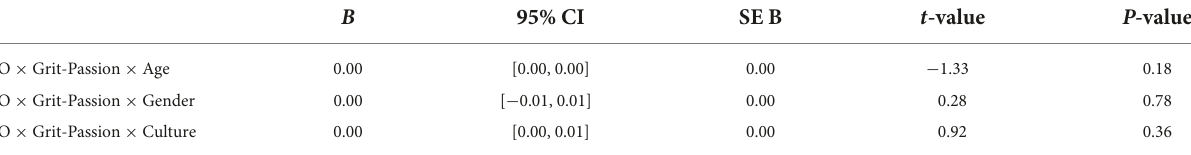
TABLE 5 Statistical significance of the interaction between EO, Grit-Passion, and sociodemographic factors. B 95% CI SE B t -value P-